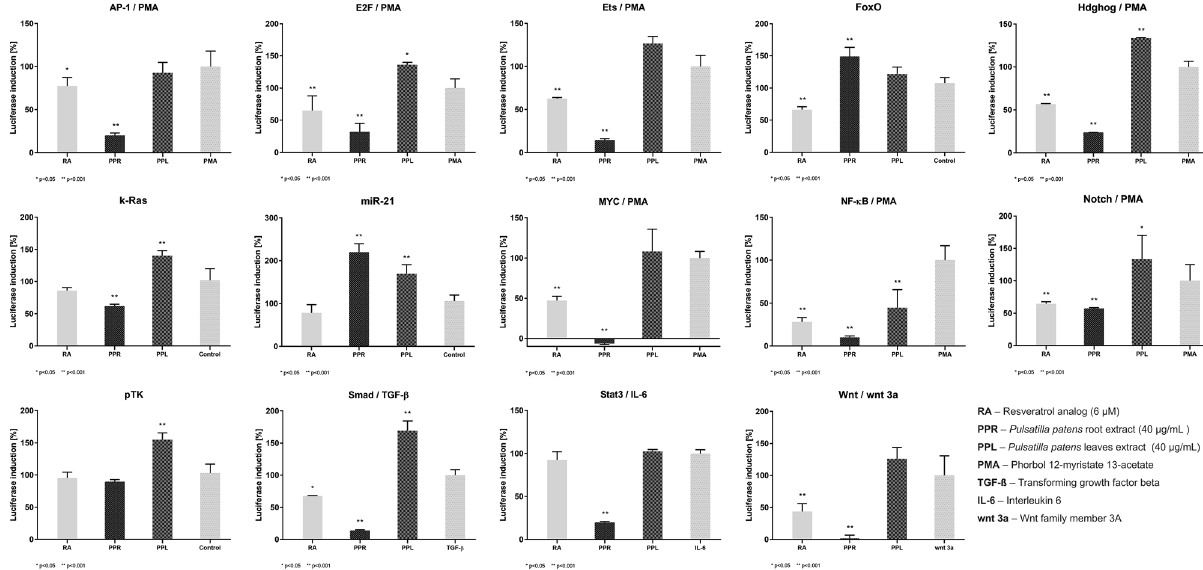
Figure 1. The inhibition of activations of Stat3, Smad, MYC, Ets, E2F, Ap-1, NF-κB, Wnt, Hdghog and pTK-control by methanolic extract of Pulsatilla patens and reference/control compound—resveratrol analog. IL-6, TGF-β, PMA, wnt 3a – Inducer (promoter) of cancer processes. Resveratrol analog – the analog 3,5,4 ′ -trihydroxy- trans -stilbene, trans -resveratrol or ( E )-resveratrol—is a stilbenoid, a type of natural